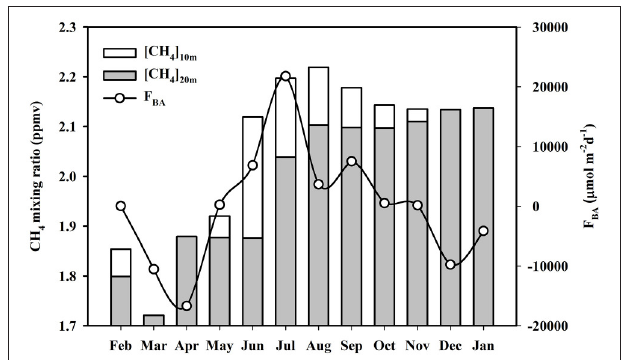
FIGURE 11 | Monthly variations of atmospheric CH 4 mixing ratio at 10 and 20m heights and biosphere-atmosphere CH 4 exchange flux (F BA